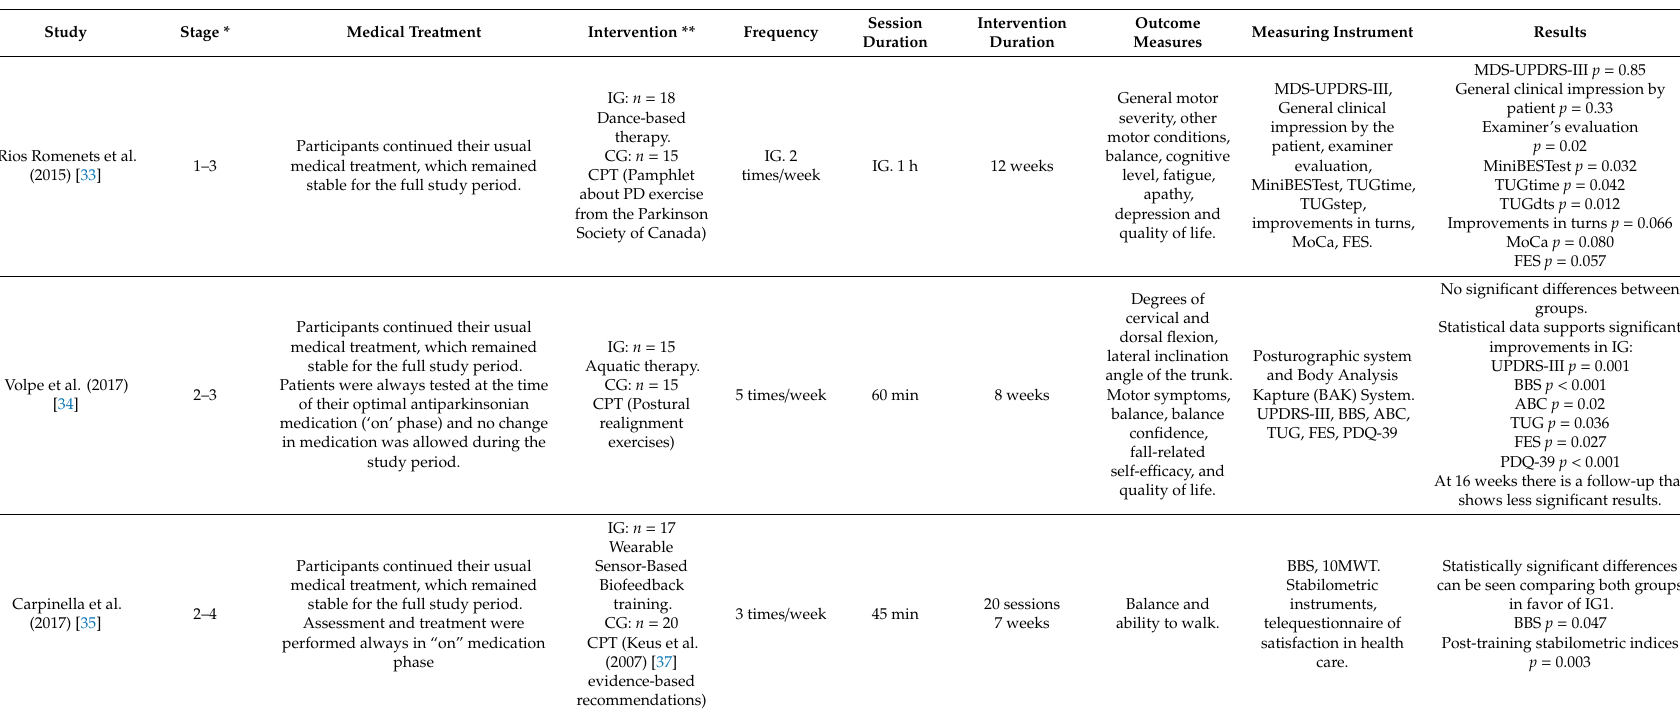
Degrees of cervical and dorsal flexion, lateral inclination angle of the trunk. Motor